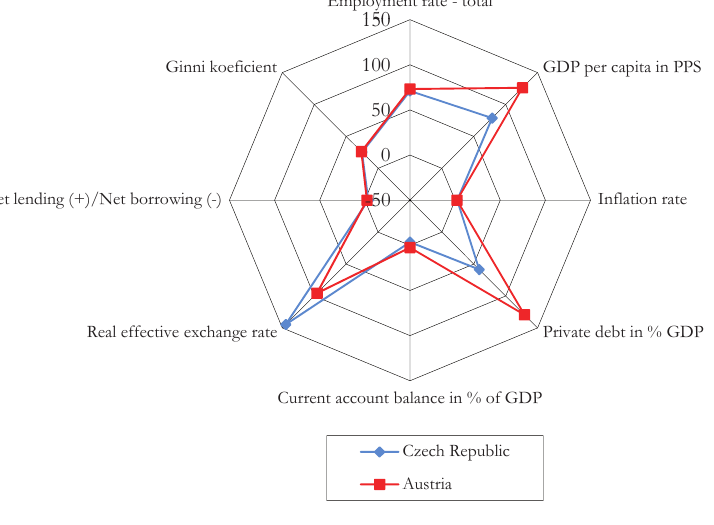
Fig. 1 – Macroeconomic indicators 2008 – 2011. Source: International Monetary